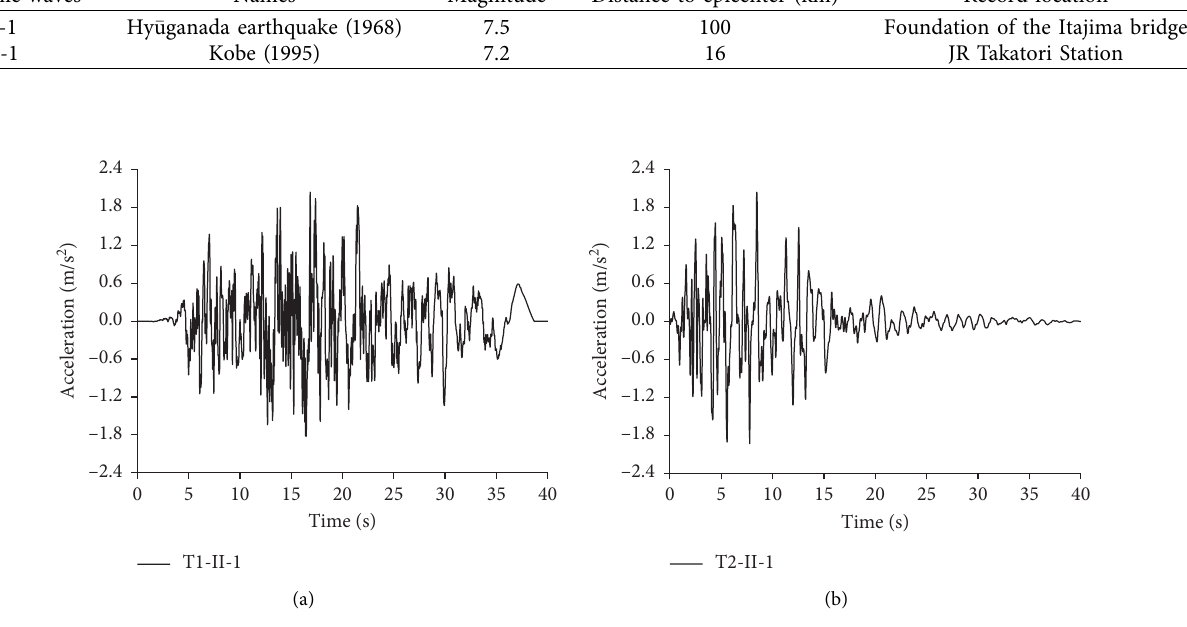
Figure 11: Time history of earthquakes. (a) T1-II-1. (b) T2-II-1. Table 8: Values of the influencing factors in the shaking table